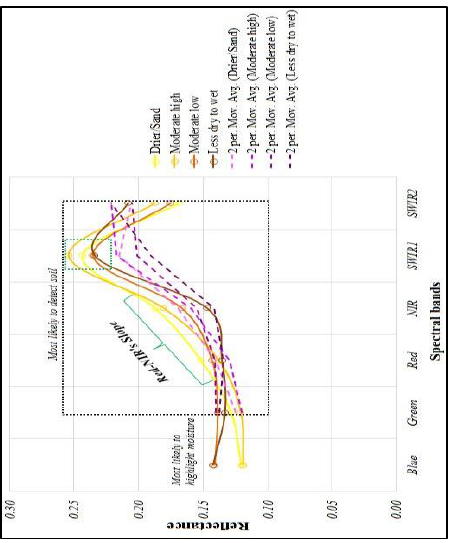
Figure 6. Features spaces. Left’s plot - Blue (X axis) Red (Y axis) ; Middle’s plot - Blue (X axis) SWIR1 (Y axis) ; Right’s plot - Red (X axis) SWIR1 (Y axis)